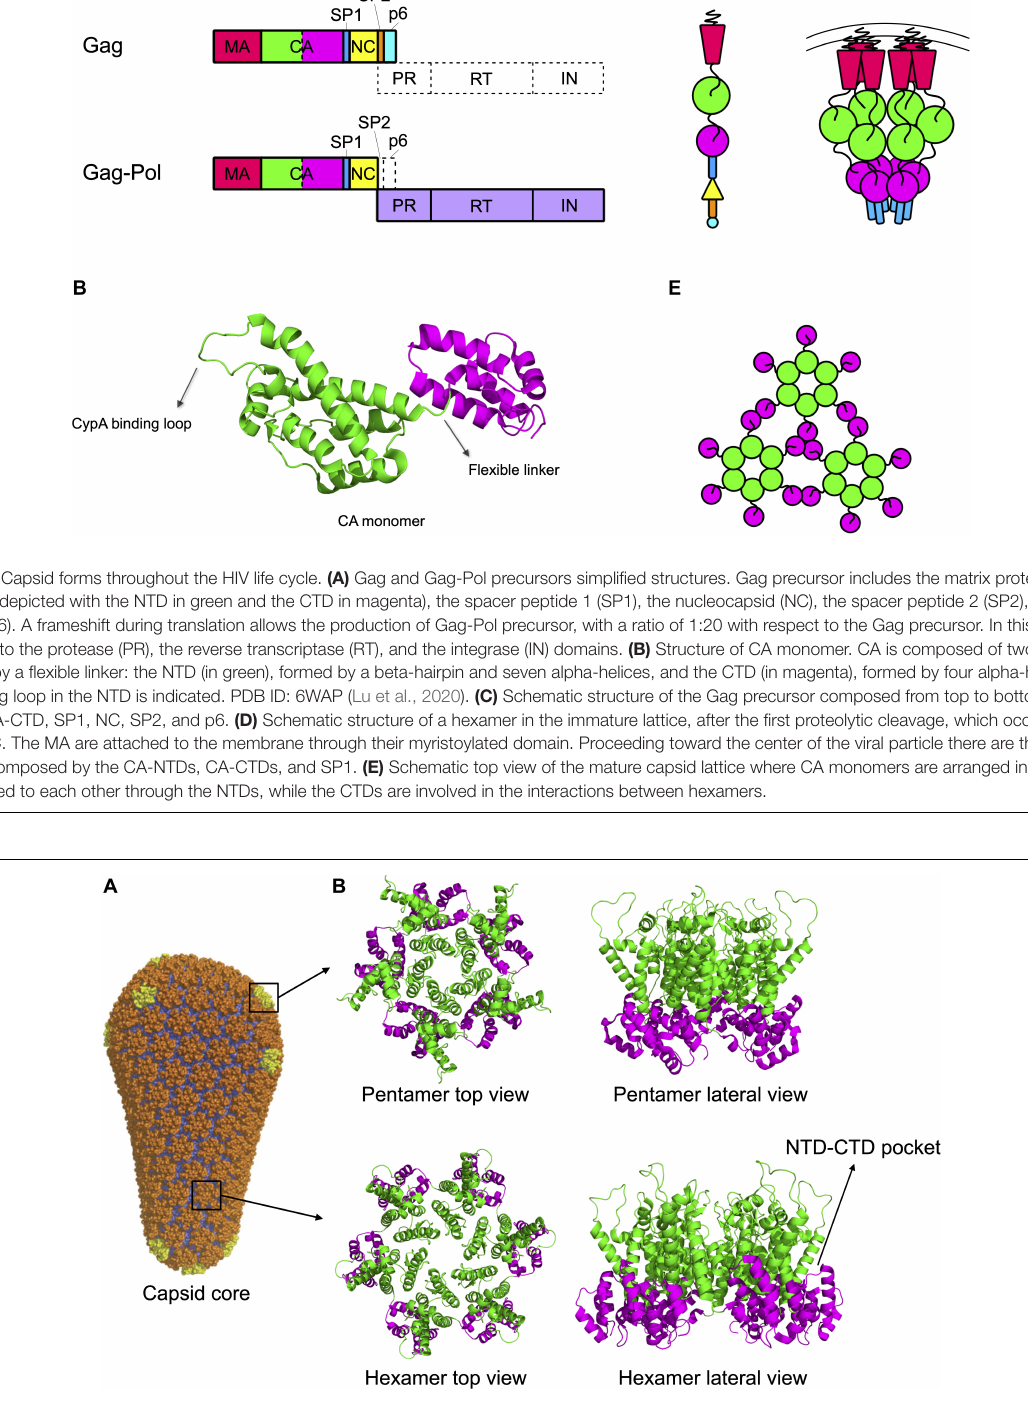
FIGURE 2 | Capsid core structure. (A) The mature capsid core has the shape of a fullerene cone, formed by 125 hexamers (in orange) and 12 pentamers (in yellow). Image republished with permission of Nature Publishing Group (Pornillos et al., 2011). (B) Top and lateral view of pentameric and hexameric capsid assemblies. In both structures, the NTDs (in green) are forming the inner ring while the CTDs (in magenta) are forming the external ring. The pocket present in the hexamer, at the NTD-CTD interface (involved in the interaction with host factors, see main text) is indicated. The pocket is absent in the pentamer. PDB IDs: 5MCX, 5MCY (Mattei et al.,